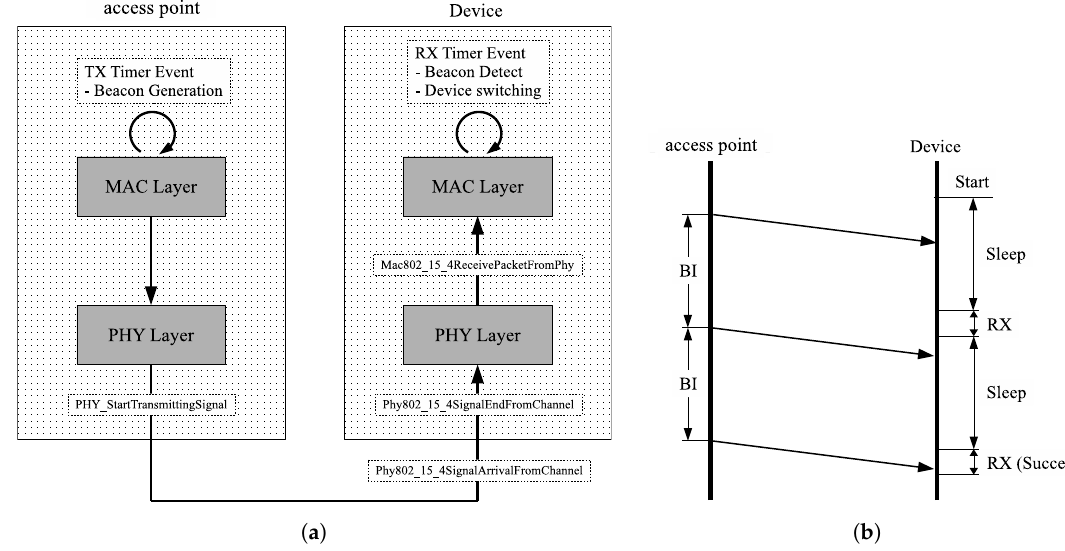
Figure 5. Configuration of simulation software: ( a ) Beacon handling process; ( b ) Example of operation